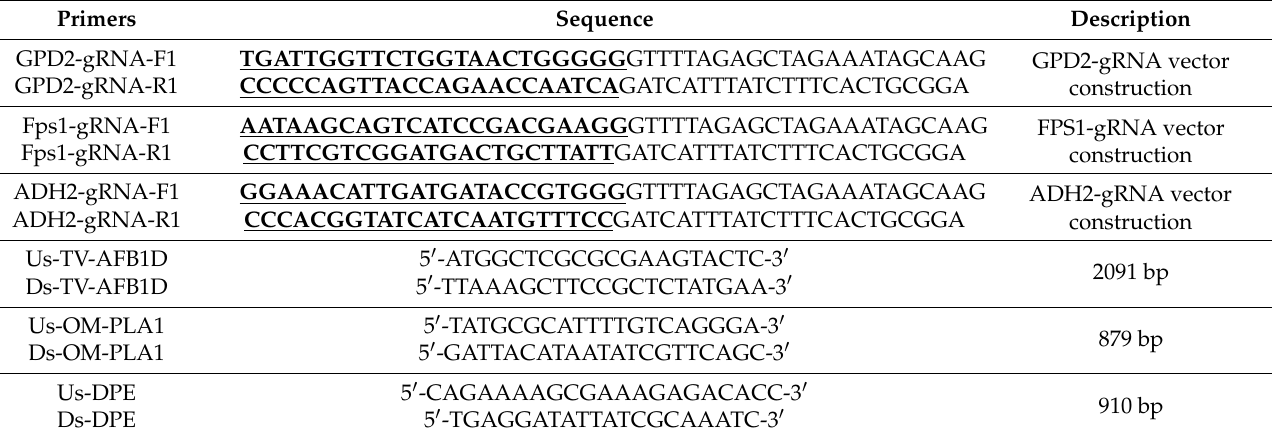
Table 1. Primers for gRNA vector construction and insertion DNA